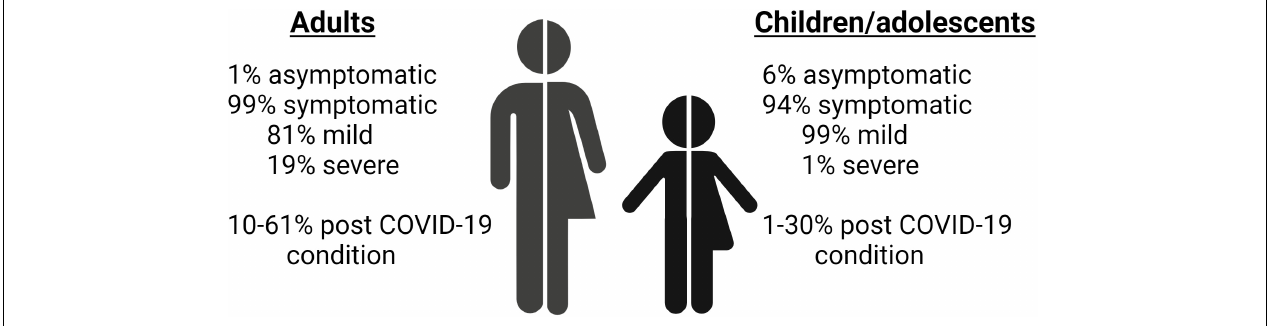
FIGURE 1 | Diagram comparing the frequencies of acute and post-COVID-19 condition between adults and children/adolescents (3–5, 31, 32, 35–38,